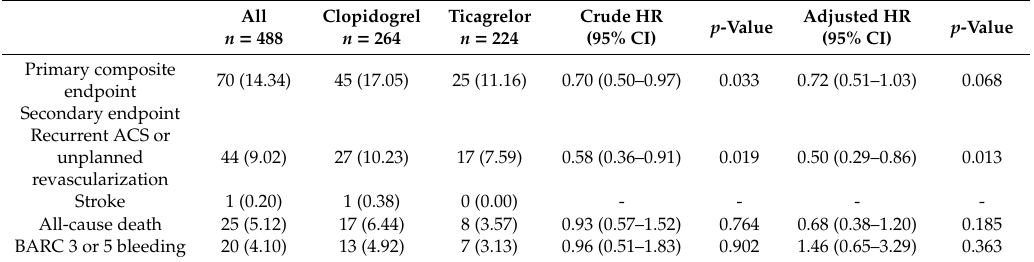
Table 4. Clinical outcomes at 12-month follow-up after removing the patients need oral